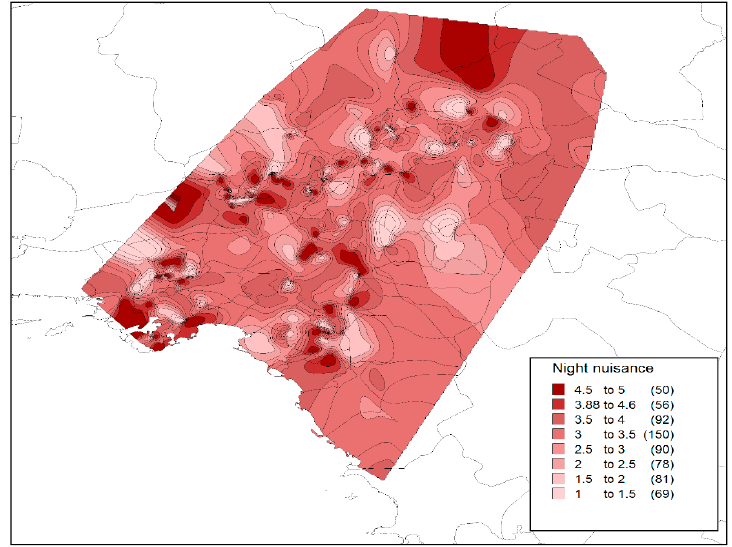
Figure 5. Night nuisance in Athens metropolitan area (Likert scale 1–5: 1, no nuisance; 5, intolerable Figure nuisance).